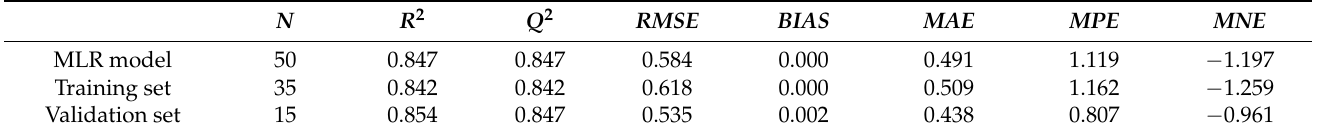
Table 3. Statistical parameters of the MLR model and the simulated external validation.